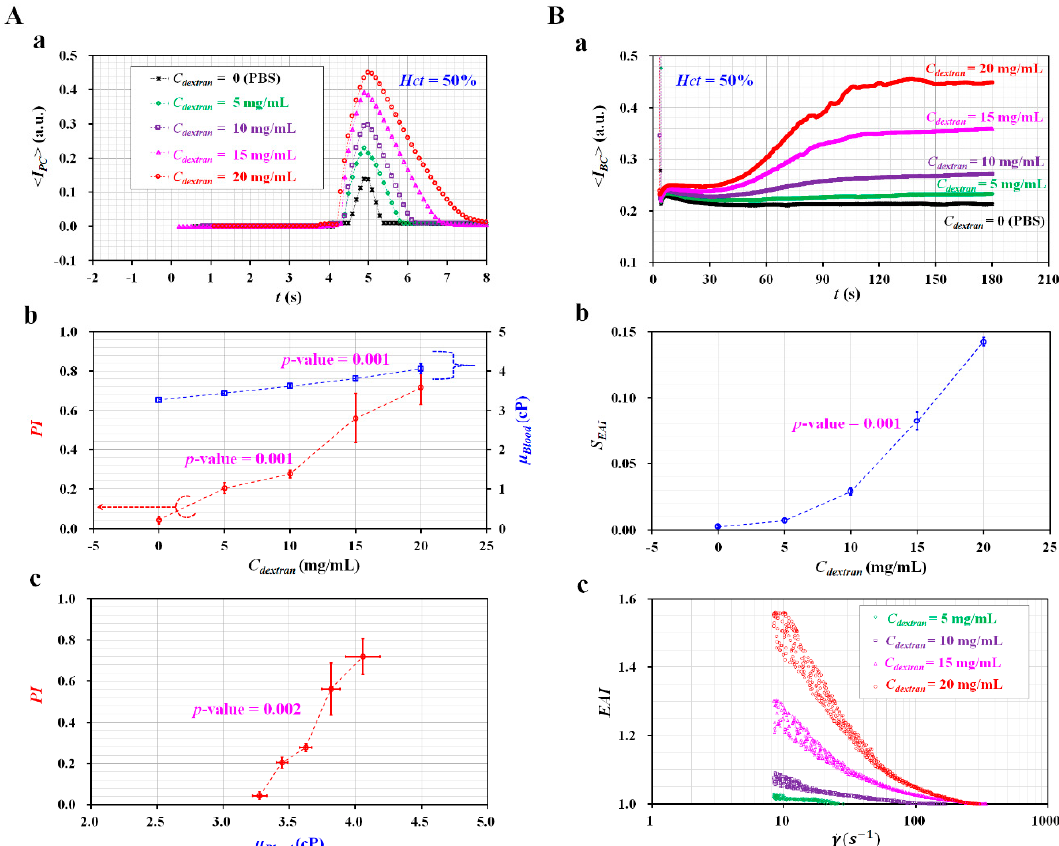
Figure 5. Performance evaluation of the proposed method for various blood samples. To enhance RBCs aggregation, hematocrit of blood sample ( Hct = 50%) was prepared by adding normal RBCs into specific concentrations of dextran solution ( C dextran = 0, 5, 10, 15, and 20 mg / mL). ( A ) Variations of pressure index ( PI ) with respect to concentration of dextran solution ( C dextran ). ( a ) Temporal variations of ∆ < I PC > with respect to C dextran . ( b ) Variations of PI and µ Blood with respect to C dextran . ( c ) Relationship between PI and µ Blood . Regression analysis exhibits a significant relationship between PI and µ